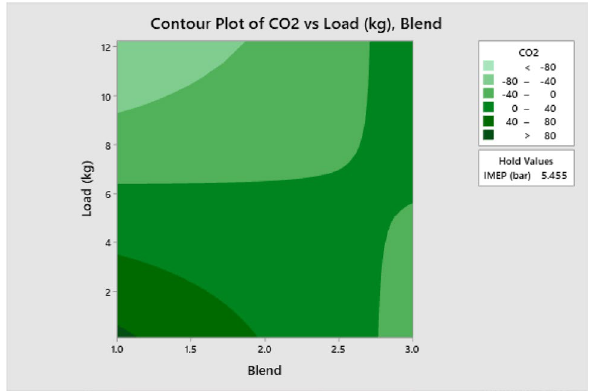
Fig. 25 Surface plot of CO without nanoparticles